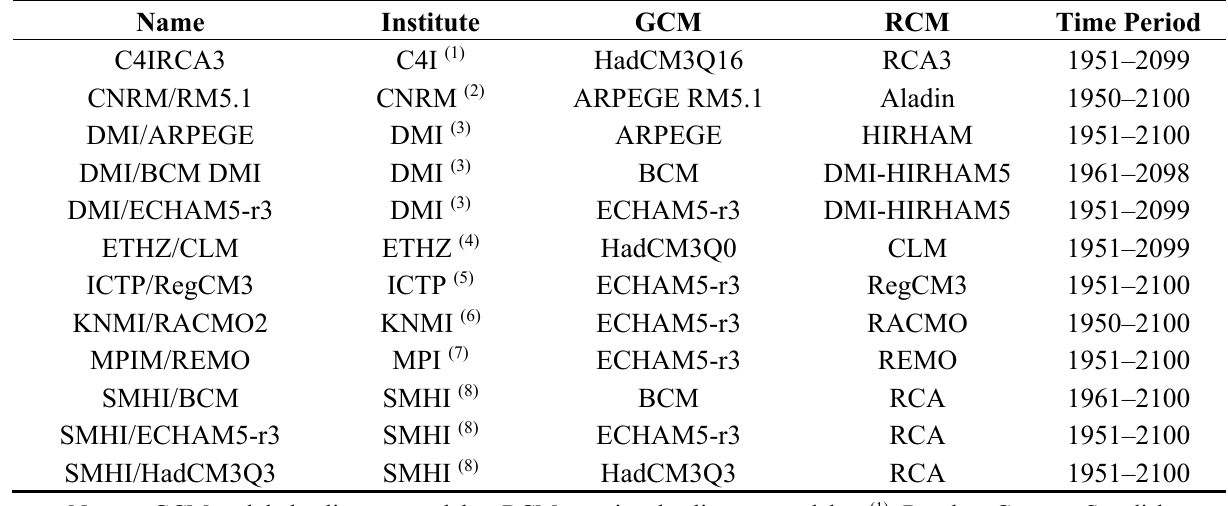
Table 2. Summary of characteristics of the selected RCMs of the ENSEMBLES